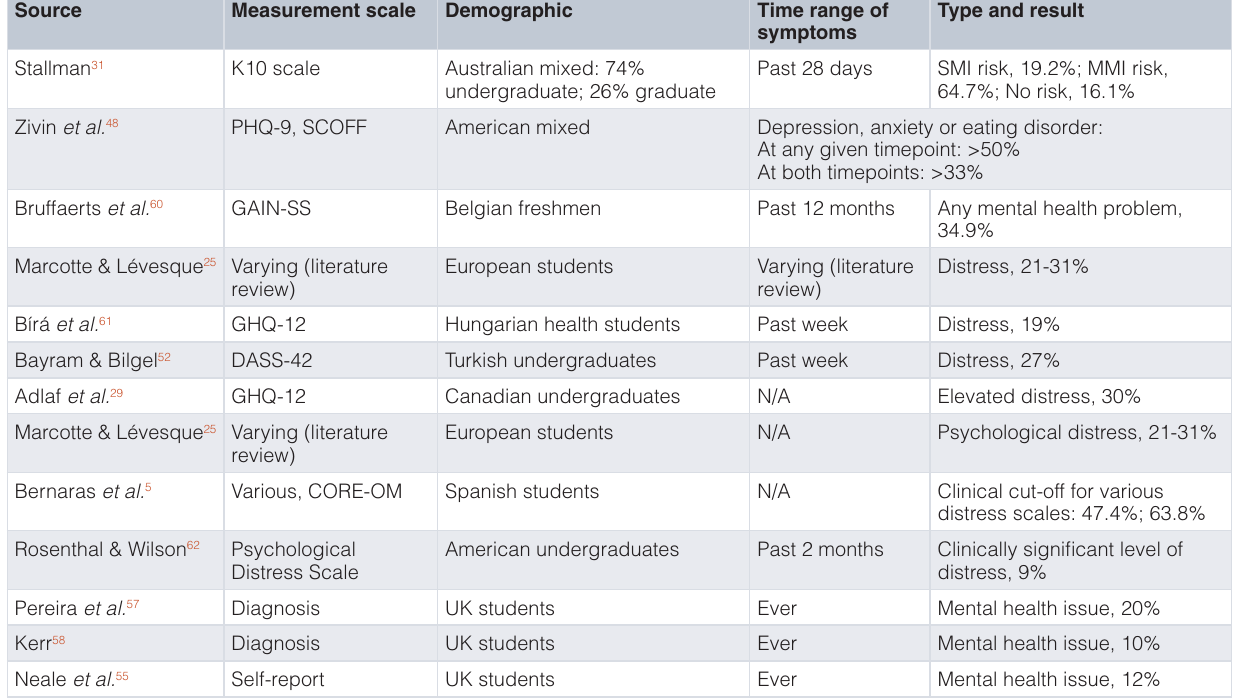
Table 5. Mental health issues and psychological distress rates among undergraduate and general student samples. Please refer to Table 1 for